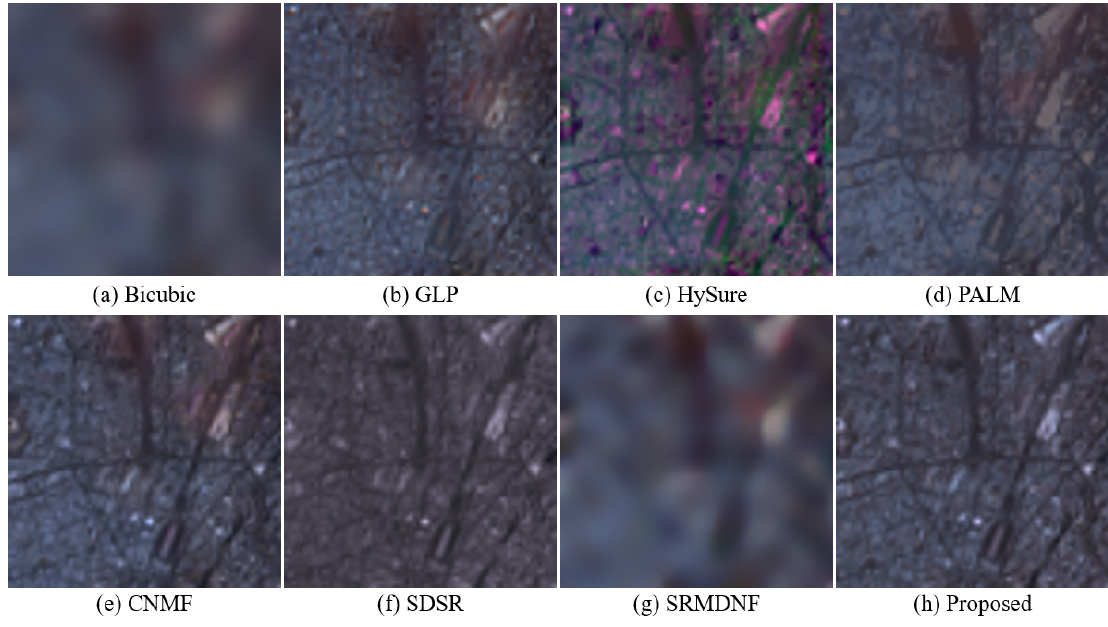
Figure 8. Super-resolution reconstruction results on the Paris dataset with a magnification factor of three. ( a ) Bicubic; ( b ) GLP; ( c ) HySure; ( d ) PALM; ( e ) CNMF; ( f ) SDSR; ( g ) SRMDNF; ( h )